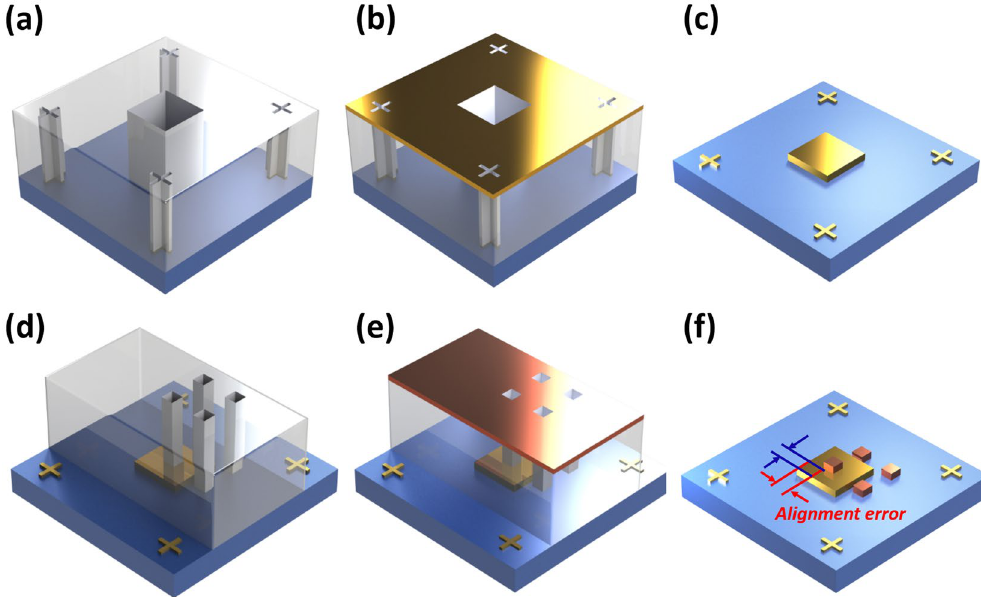
Figure 1. Schematic of conventional EBL overlay process. ( a ) Alignment marks and first layer patterning process on the copolymer (MMA) and polymethyl methacrylate (PMMA) bilayer resists. ( b ) Material deposition and lift-off process. If one wants to use different materials in patterned area and alignment marks, or to execute multiple EBL overlay processes, the alignment marks should be blocked to prevent the material deposition during the first layer patterning. ( c ) Fabricated alignment marks and first layer patterns. ( d ) Subsequent EBL overlay process (the second layer patterning) with the pre-defined alignment marks.